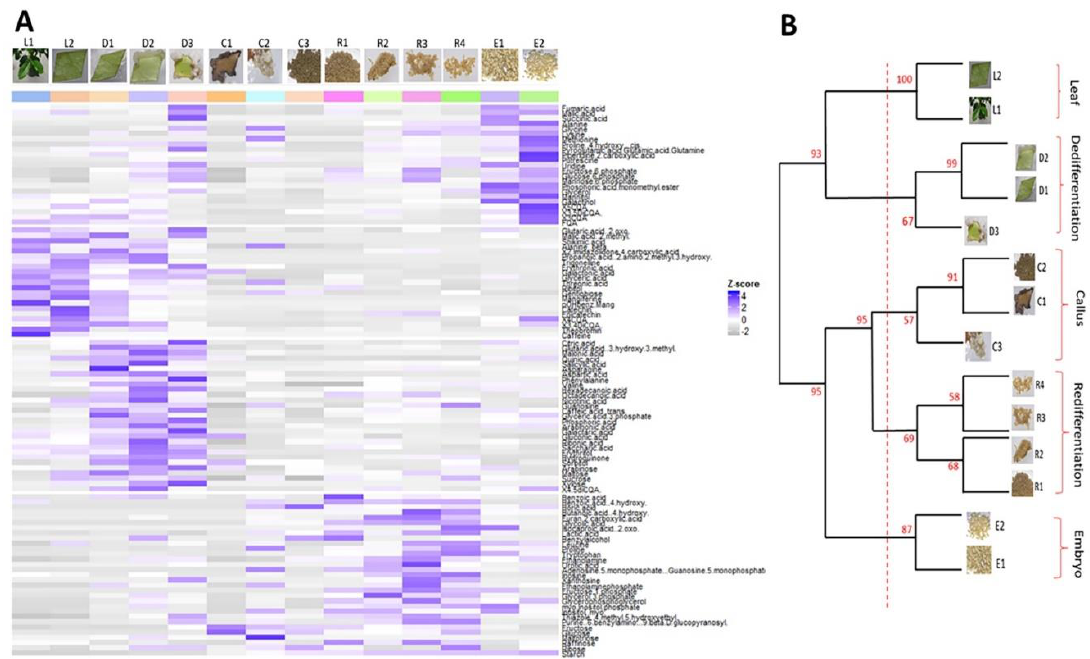
Figure 3. Profiling primary and secondary metabolites during 14 key sampled stages of the Arabica somatic embryogenesis process. ( A ) Heatmap generated from the Z-score values of a total of 92 primary metabolites and 12 secondary metabolites detected. Rows correspond to metabolites and columns to the sampled stages. Positive Z-score values are shown in blue and negative values in grey. ( B ) Hierarchical clustering of the 14 sampled stages according to the similarities in their metabolic profiles. The clustering was performed using Pearson’s correlation coefficient. Cluster probabilities were calculated via a multiscale bootstrap with a total of 1000 iterations. Clustering yielded 5 major nodes: Leaf, Dedifferentiation, Callus, Redifferentiation and Embryo.